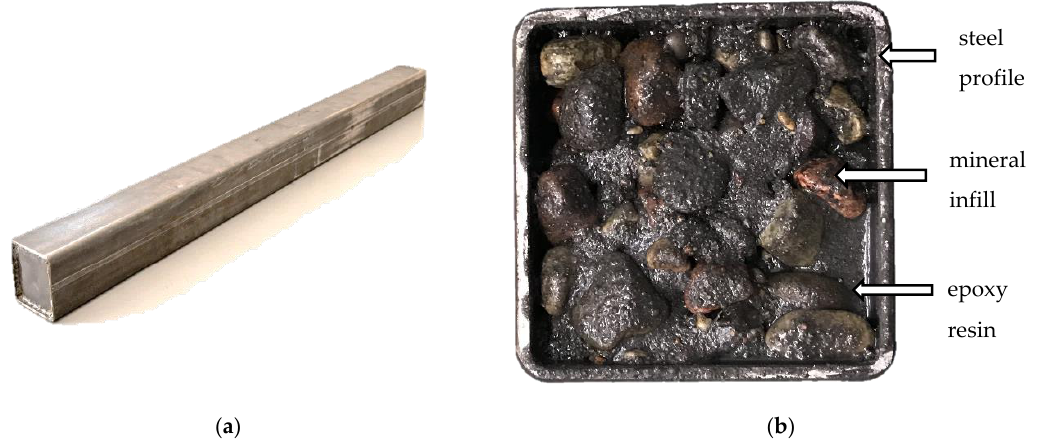
Figure 1. Steel–polymer concrete beam ( a ) general view; ( b ) cross-section view.